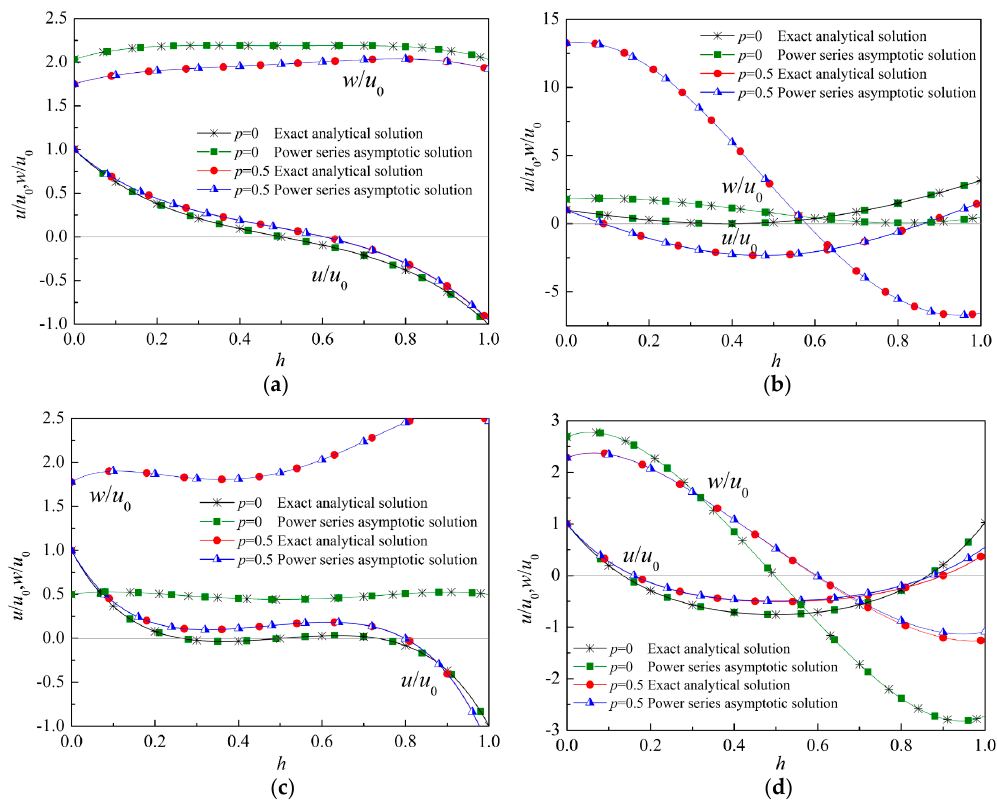
Figure 4. Wave structure. ( a ) kh = π , Mode 1, ( b ) kh = π , Mode 2, ( c ) kh = 2 π , Mode 1, ( d ) kh = 2 π ,